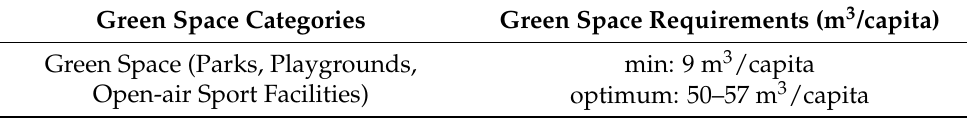
Table 10. Green space requirements per capita.